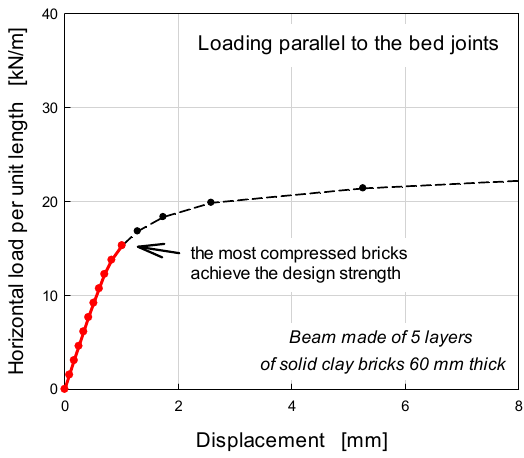
Figure 8. FEM: load-displacement curve for a masonry beam reinforced by flax fiber under horizontal loads.